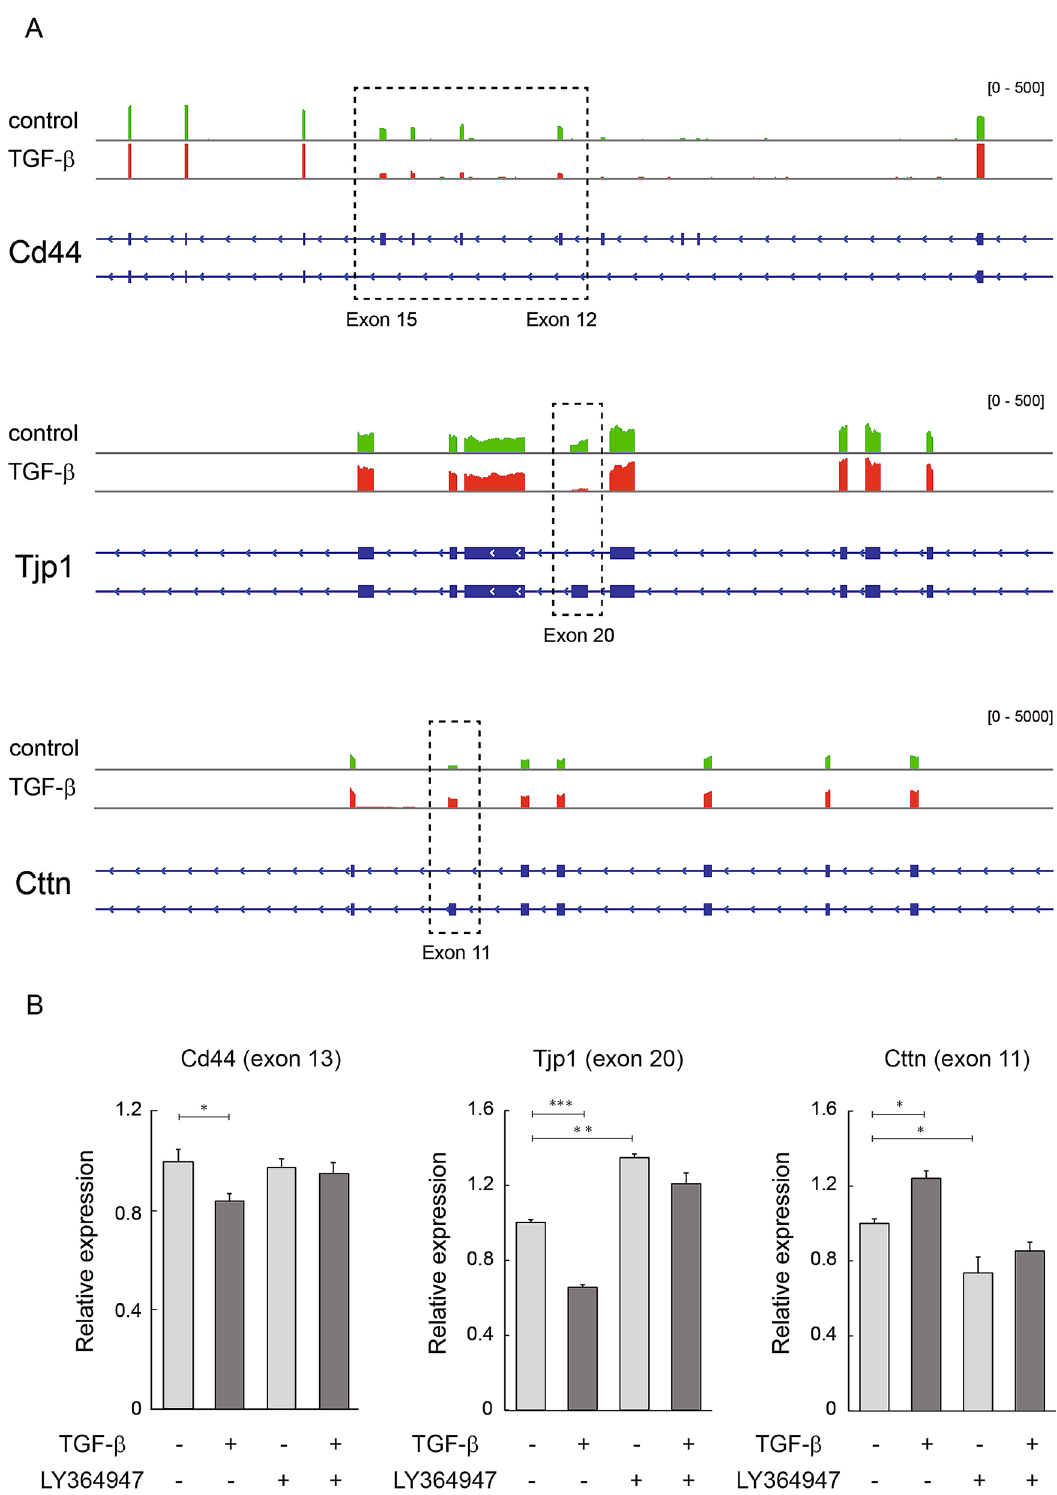
Figure 4. Differential splicing is induced by TGF-β in CMT64 cells. ( A ) Alternative transcripts for genes involved in ECM-cell interactions (Cd44), cell junction (Tjp1), and cytoskeletal organization (Cttn). Dotted square indicates the exons of alternative splicing by TGF-β treatment. Expression levels determined by RNA- seq in CMT64 cells cultured with or without 5 ng/ml of TGF-β for 24 h were shown by Integrative Genomics Viewer. ( B ) Quantitative RT-PCR was performed for Cd44 exon 13, Tjp1 exon 20, and Cttn exon 11 in CMT64 cells treated with 5 ng/ml of TGF-β for 24 h in the presence or absence of 3 μM of LY364947. LY364947 or DMSO was added 1 h before TGF-β treatment. Expression levels were normalized to that of Gapdh. Error bars: